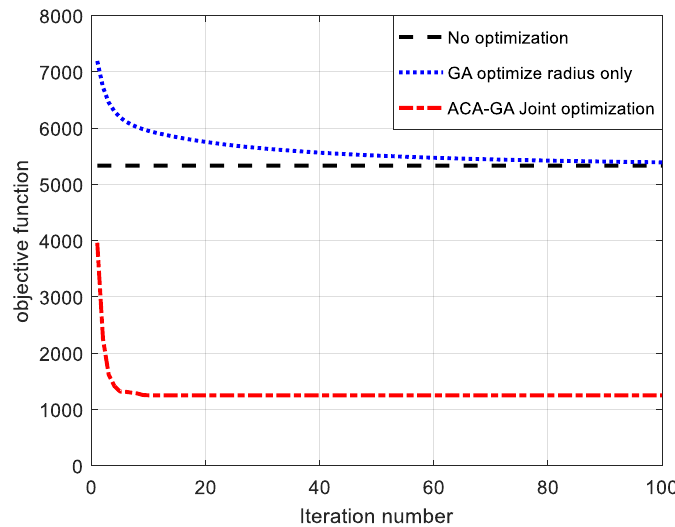
Figure 6. Network capacity in three different optimization methods ( N = 20).